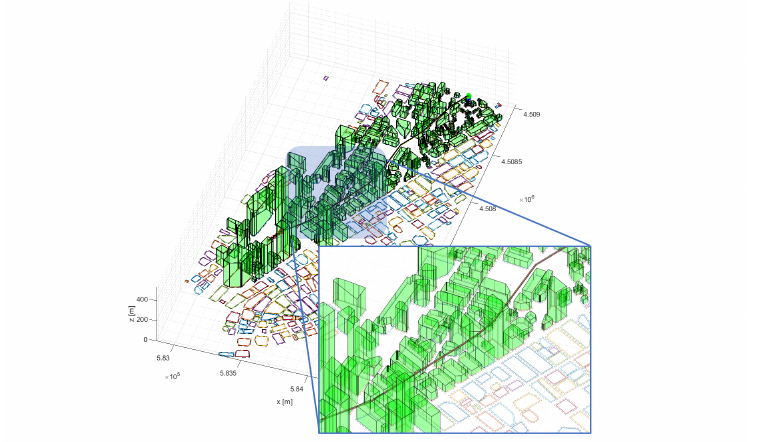
Figure 15. Example of a 3-D geofence wrapping a “turn” flight plan solution. Polyhedra in green denote keep-out geofences around buildings near the trajectory’s keep-in geofence. The remaining 2-D polygons denote keep-out geofences around buildings that are more distant from the sUAS flight path.